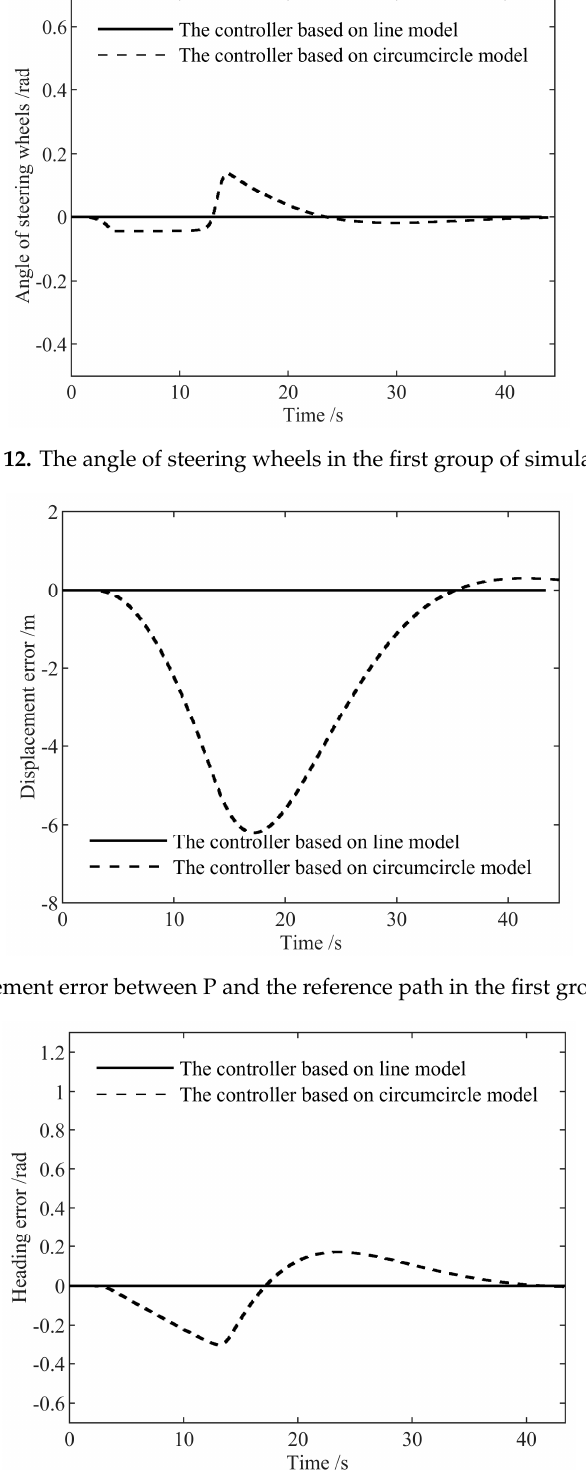
Figure 14. Heading error between the tractor and the reference path in the first group of simulations.